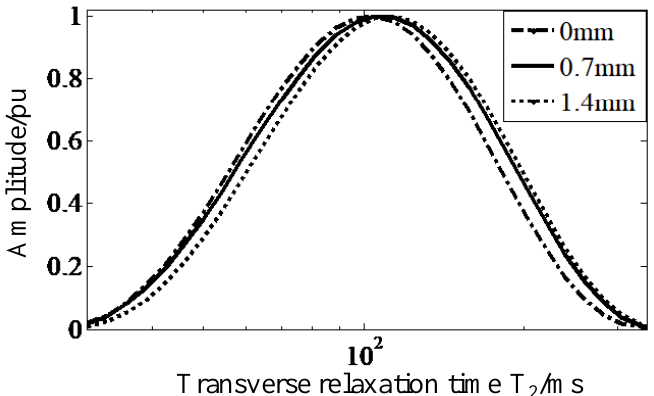
Figure 16. The T 2 distribution of C1 at different depths.